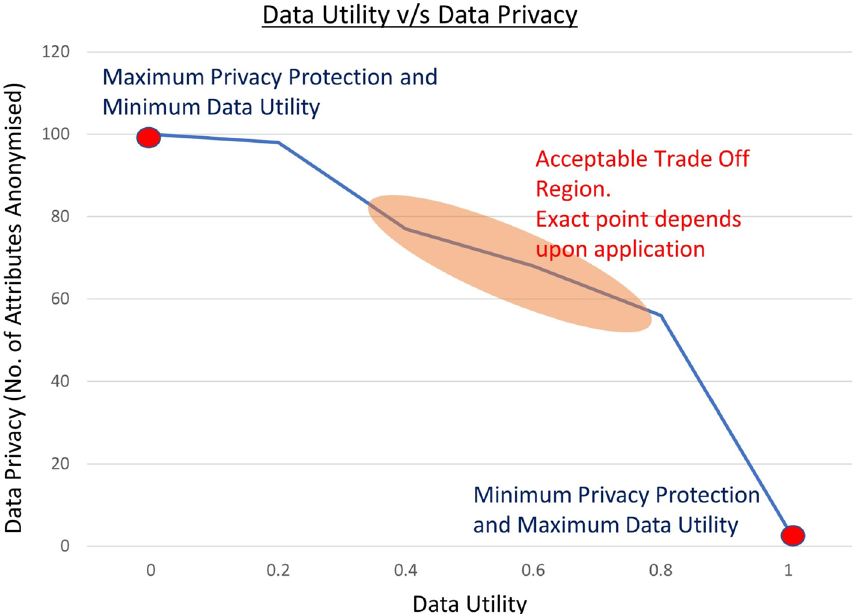
Fig. 2 Data utility and data privacy trade